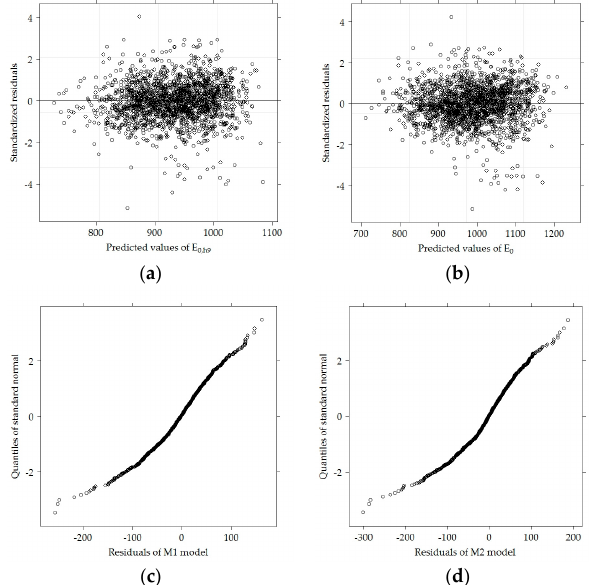
Figure 26. Residual values of models M1 and M2: ( a ) diagnostic of estimated M1 model: predicted values of E 0,h9 versus standardized residuals; ( b ) diagnostic of estimated M2 model: predicted values of E 0 versus standardized residuals; ( c ) diagnostic of estimated M1 model: residuals versus quantiles of standard normal distribution; ( d ) diagnostic of estimated M2 model: residuals versus quantiles of standard normal distribution.